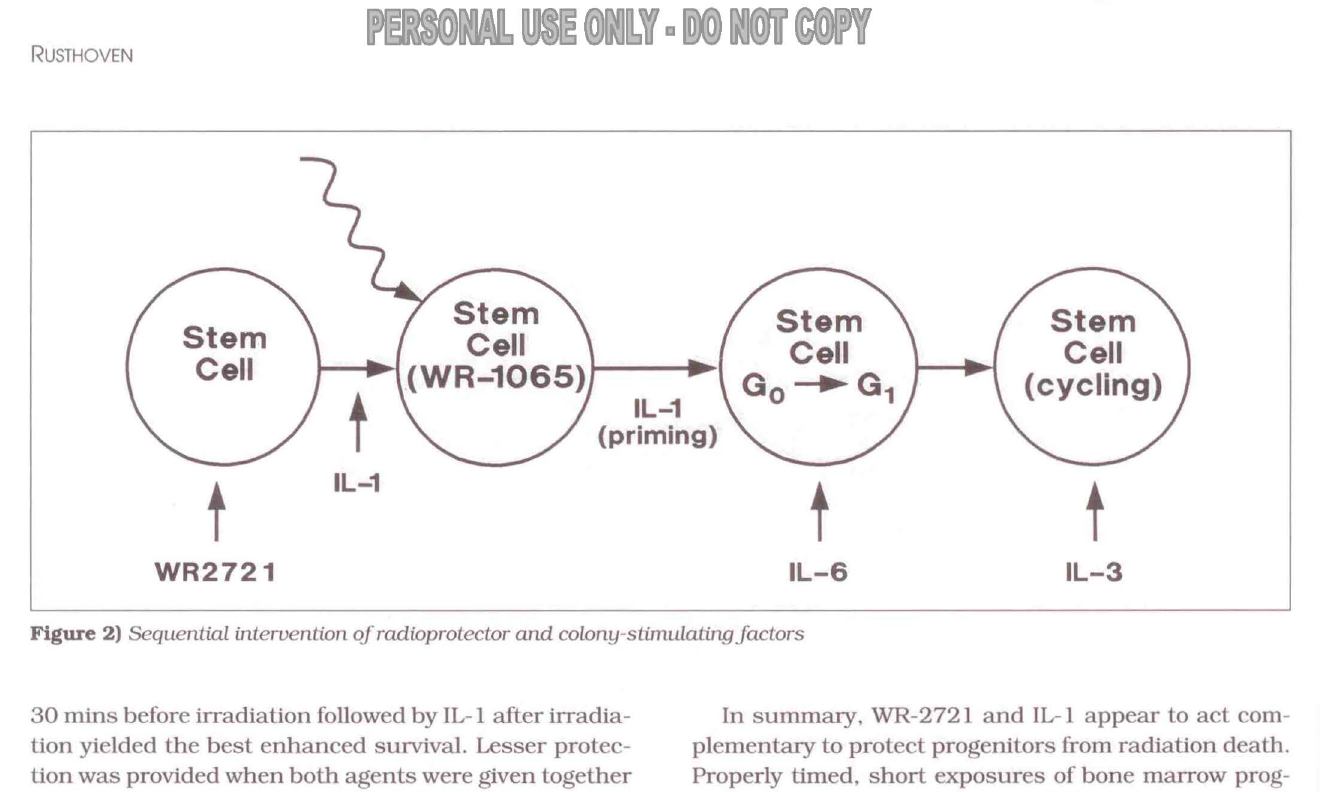
30 rnins before irradiation followed by IL-l after irradia tion yielded the best enhanced survival. Lesser protec tion was provided when both agents were given together just before irradiation. Weiss et al (39) hypothesized that WR-2721 may act as a true radioprotector without inducing progenitor